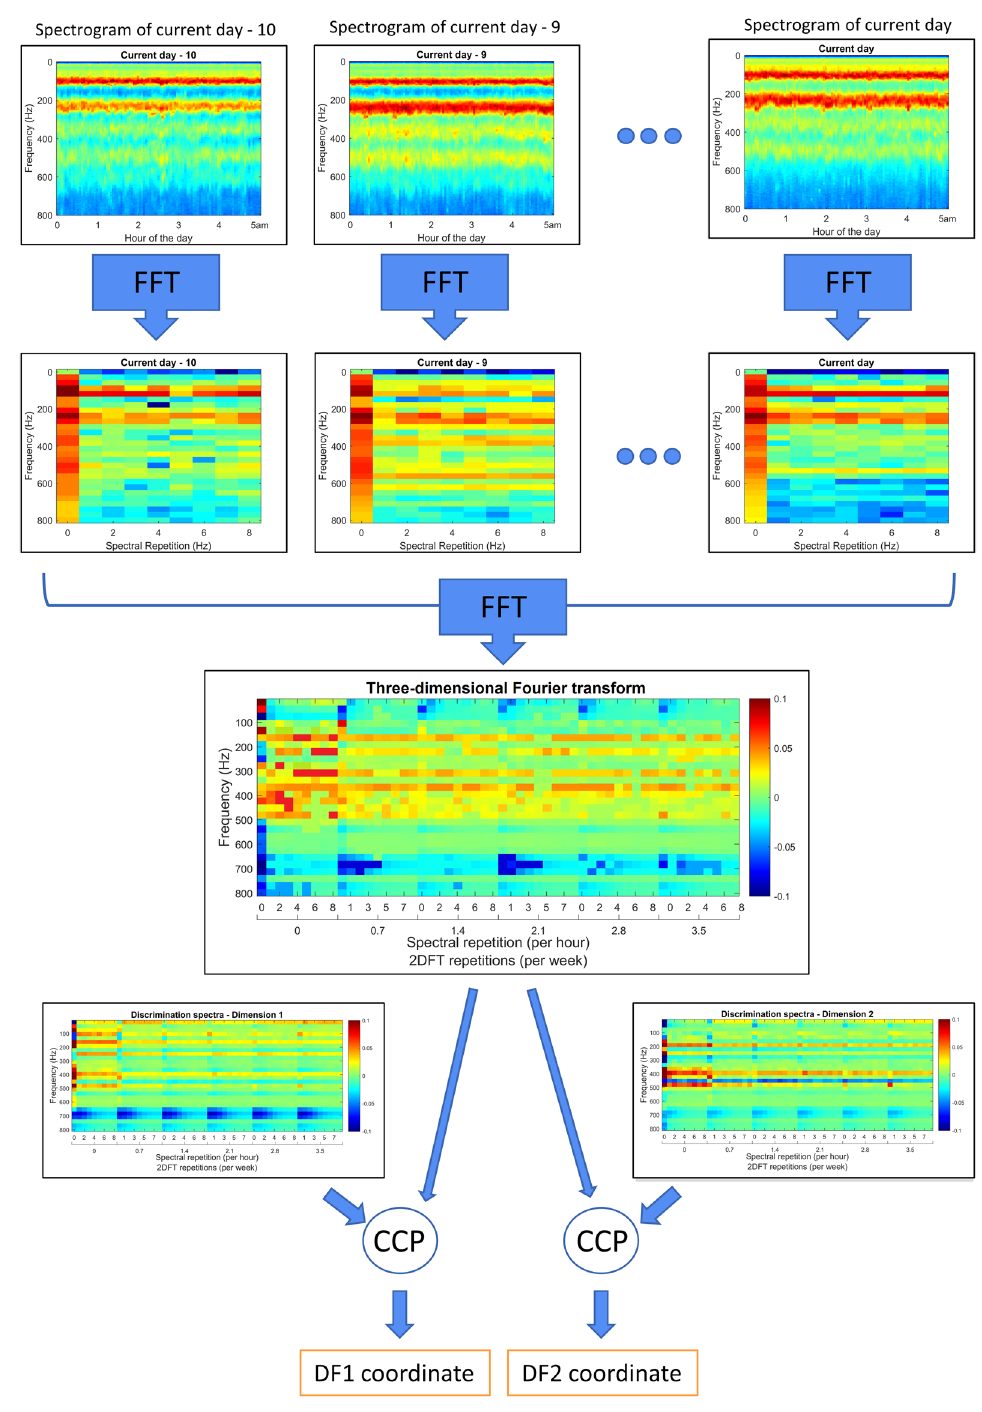
Figure 4. The spectral evolution alarm procedure. The images here are solely for illustrative purposes. This figure depicts the process for the detection of swarming in the post-training phase. In order to account for the history of the vibrational spectra, the FFT (Fast Fourier Transform) is performed on the time course of the magnitude of all the uploaded spectral frequencies for each day between midnight and 5:00 AM, yielding 2DFT (two dimensional Fourier Transform) images (second line). The FFT is then further calculated over each pixel of the series of 2DFTs found in the preceding days (third line). Each 3DFT (three dimensional Fourier Transform) is compared to a pair of Discriminant Functions, as determined by the DFA algorithm (Fig. 5), using the cross- correlation product (CCP), the values of which determine the co-ordinates for a single point in the DF space. The remainder of the procedure is identical to that described in Fig. 1. In this figure, for ease of representation, we give an example using two discriminant functions, however, in this study, three discriminant functions were used. Plots used in the creation of this figure were generated using the MATLAB (R2018b) software (uk.